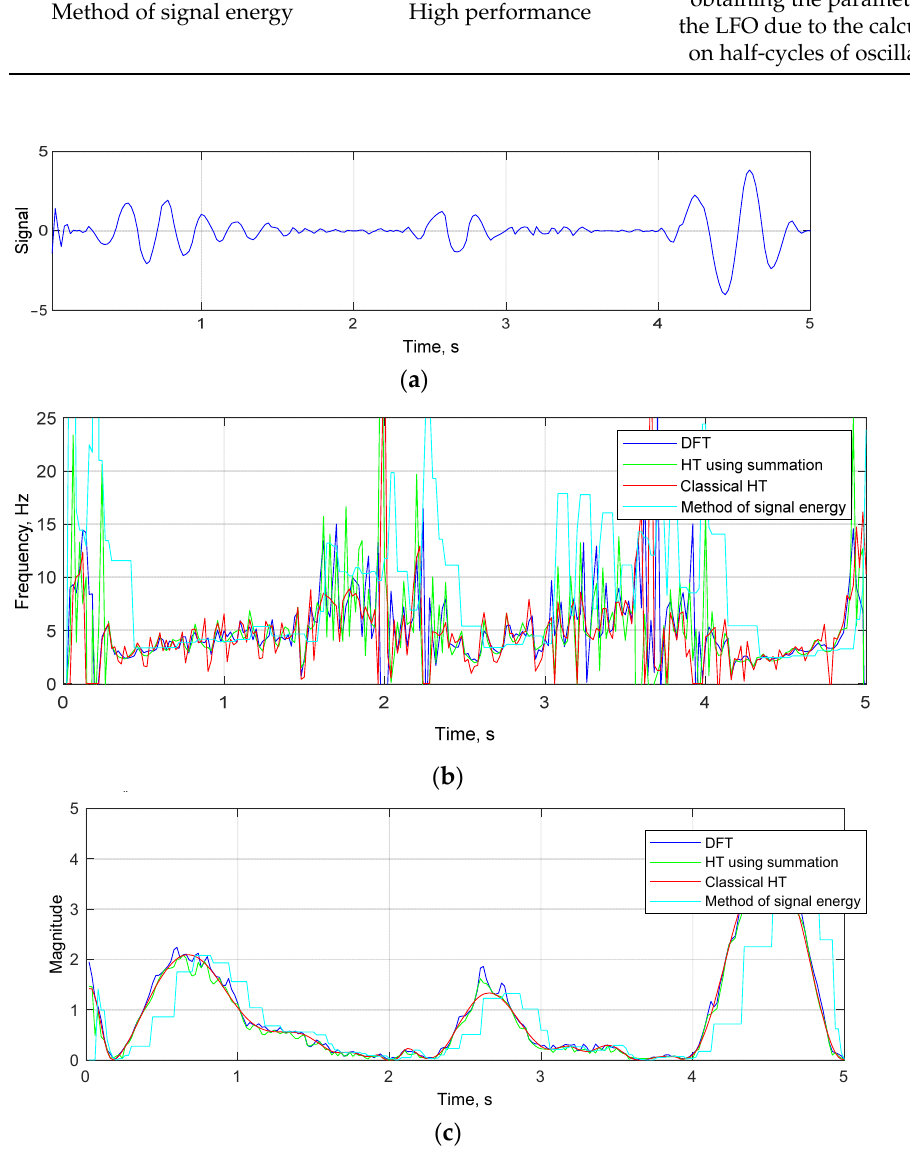
Figure 2. The results of mode component calculation for each method: ( a ) initial signal; ( b ) signal frequencies; ( c ) signal magnitudes. Table 1. Comparison of existing methods for LFO analysis.